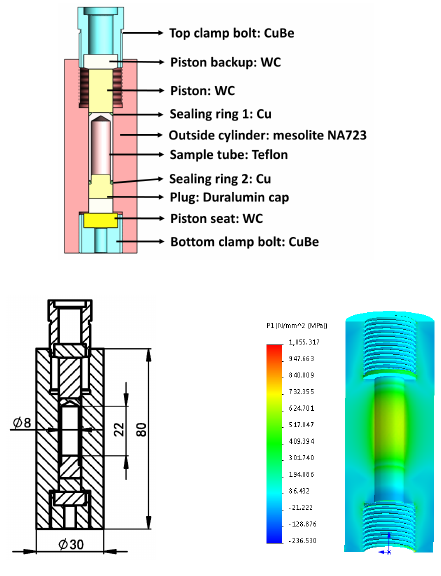
Fig. 2. The sketch, dimensions, and maximum stress distribution with FEA are shown for the HSA –